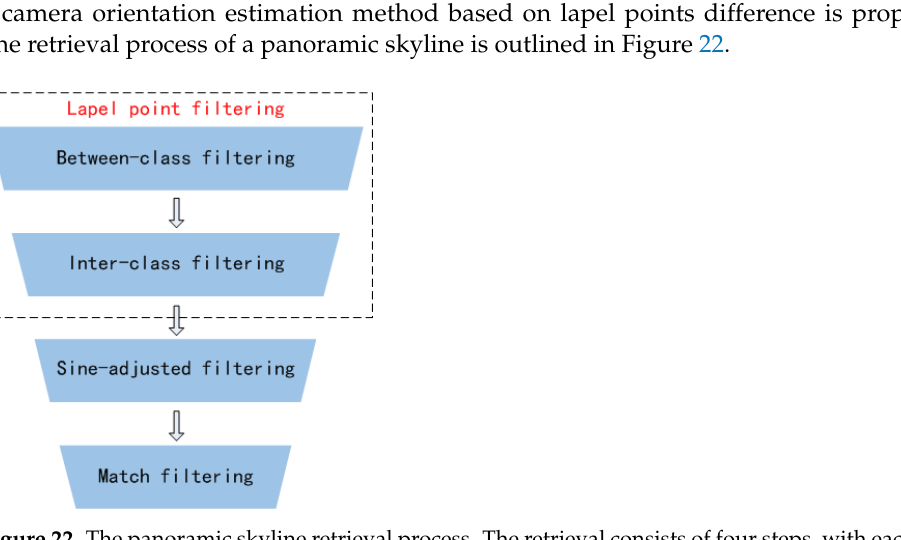
Figure 22. The panoramic skyline retrieval process. The retrieval consists of four steps, with each step filtering out some candidate points, and the last step sorting them according to the matching results.